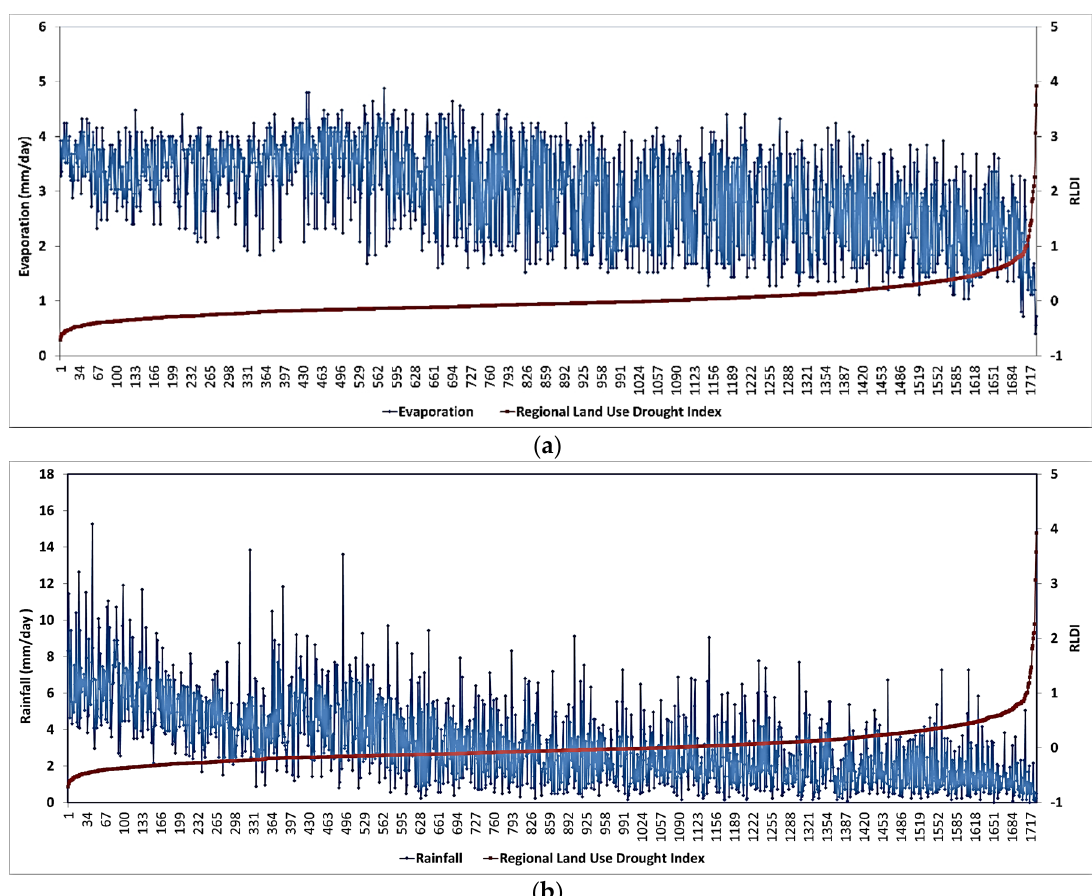
Figure 12. ( a ) Relationship between Sorted RLDI and Evaporation; ( b ) Relationship between Ordered RLDI and Rainfall.